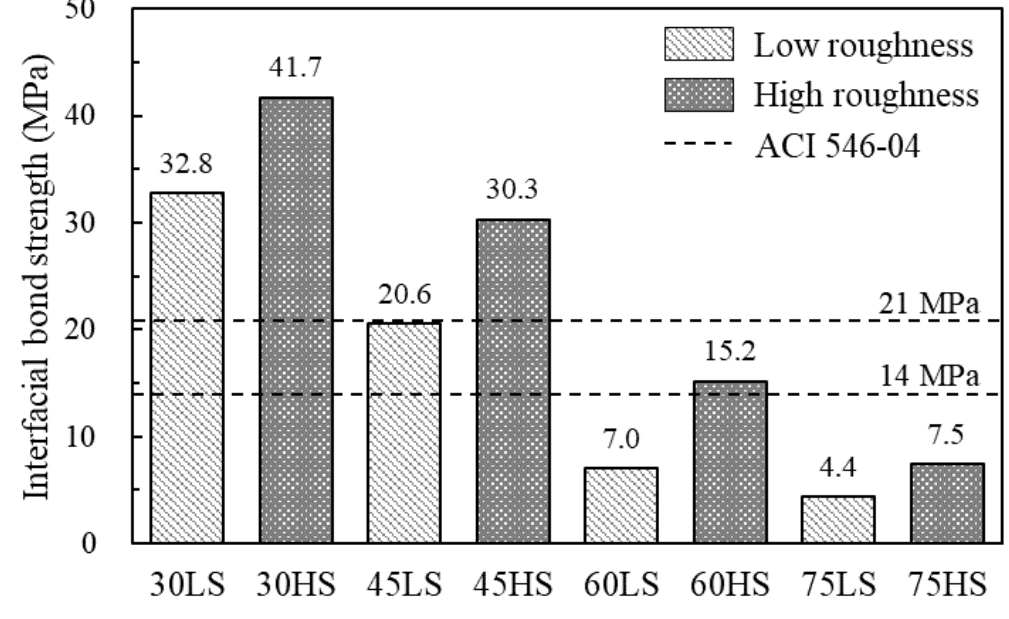
Figure 7. Interfacial bond strength behavior.